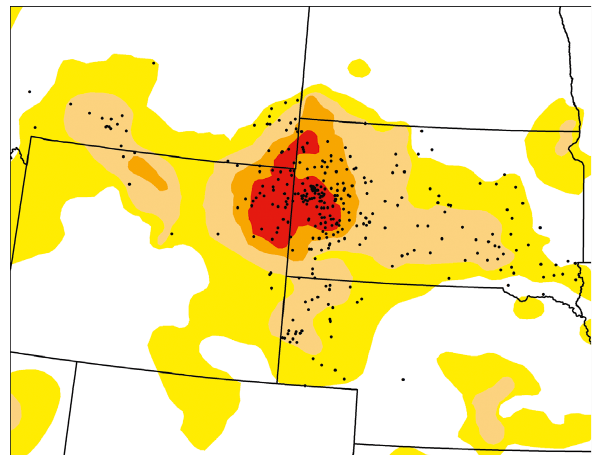
Figure 1: Points represent the approximate locations of survey respondents and are randomly distributed within respondents’ zip codes, to protect individual identities. The colors on the map represent the U.S. Drought Monitor designation as of July 26, 2016, with yellow indicating abnormal dryness, tan indicating moderate drought, orange indicating severe drought, and red indicting ex- treme